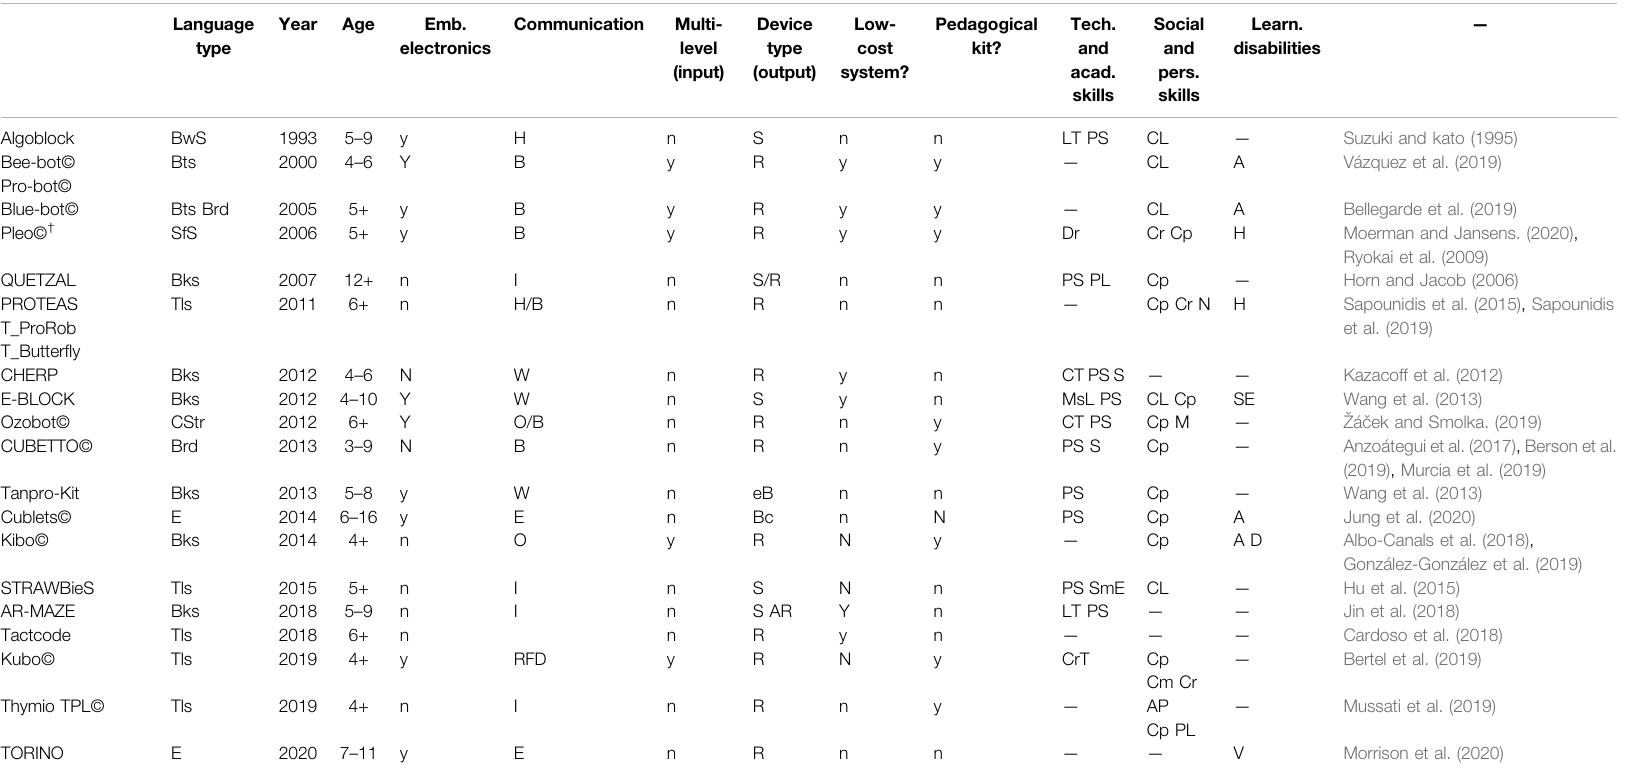
TABLE 1 | Comparing different tangible solutions. Programming languages were de fi ned as blocks with switches (BwS), buttons (Bts), sequence of commands board (Brd), surface sensors (SfS), paper tiles (Tls), colour strips (CStr)and embodied (E). The communication to the output device is hardwired (H), by Bluetooth (B), image processing (I), wireless (W), optical device (O), RFID (RFD) or embedded (E). The output device isa robot (R)orascreen(S),ascreenwithaugmentedreality(AR),anelectronicboard(eB)oranelectronicblockscon fi guration(Bc).TechnicalandAcademicSkillswereidenti fi edascomputationalthinking(CT),logical(LT)andcritical thinking(CrT), problem-solving skills (PS),using drawings for programming (Dr),ability touseand understand programming language (PL), sequencing (S), developing ofmultisensory (MsL) and sensorimotor (SmE) skills.At Social and Personal skills, collaborative learning (CL), negotiation (N), creativity (Cr), Cooperation and collaboration (Cp) motivation (M), communication (Cm), active participation (AP), playful or fun (PL) were found in the bibliography. Finally, for Learning disabilities were identi fi ed Autism Spectrum Disorders (A), children in hospitalization (H), Down Syndrome (D), special needs(SE) and visual disabilities